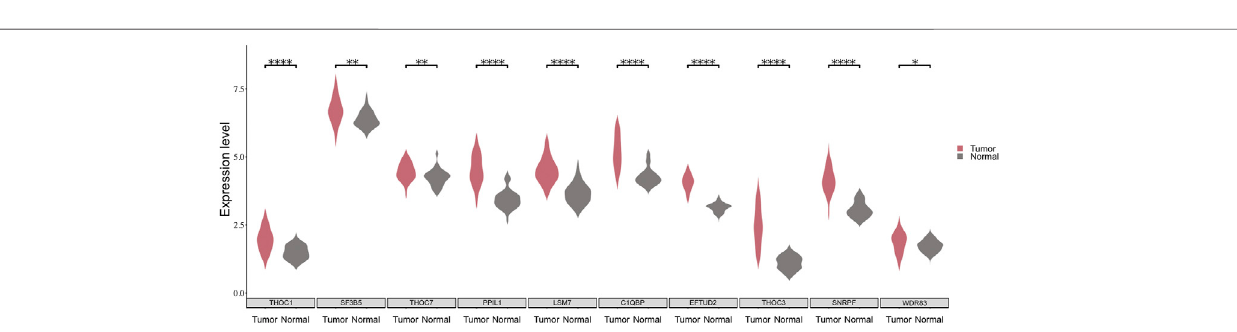
FIGURE 5 | The expression distribution of 10 SFs between cancerous and paraneoplastic tissues in the TCGA dataset. The horizontal axis represents the expression of genes. The vertical axis shows the 10 key SFs.